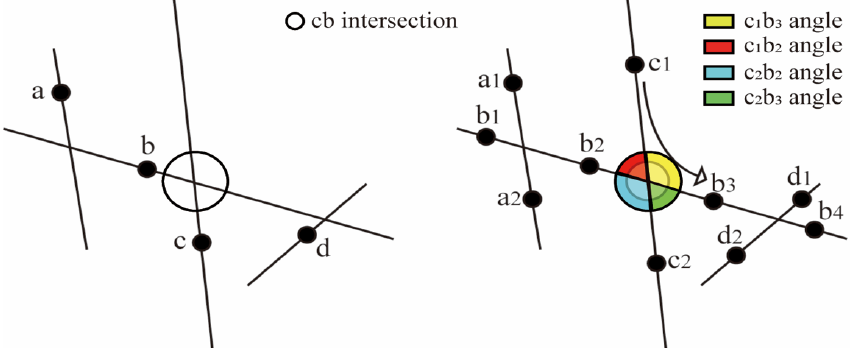
Figure 3. Axial map and segment